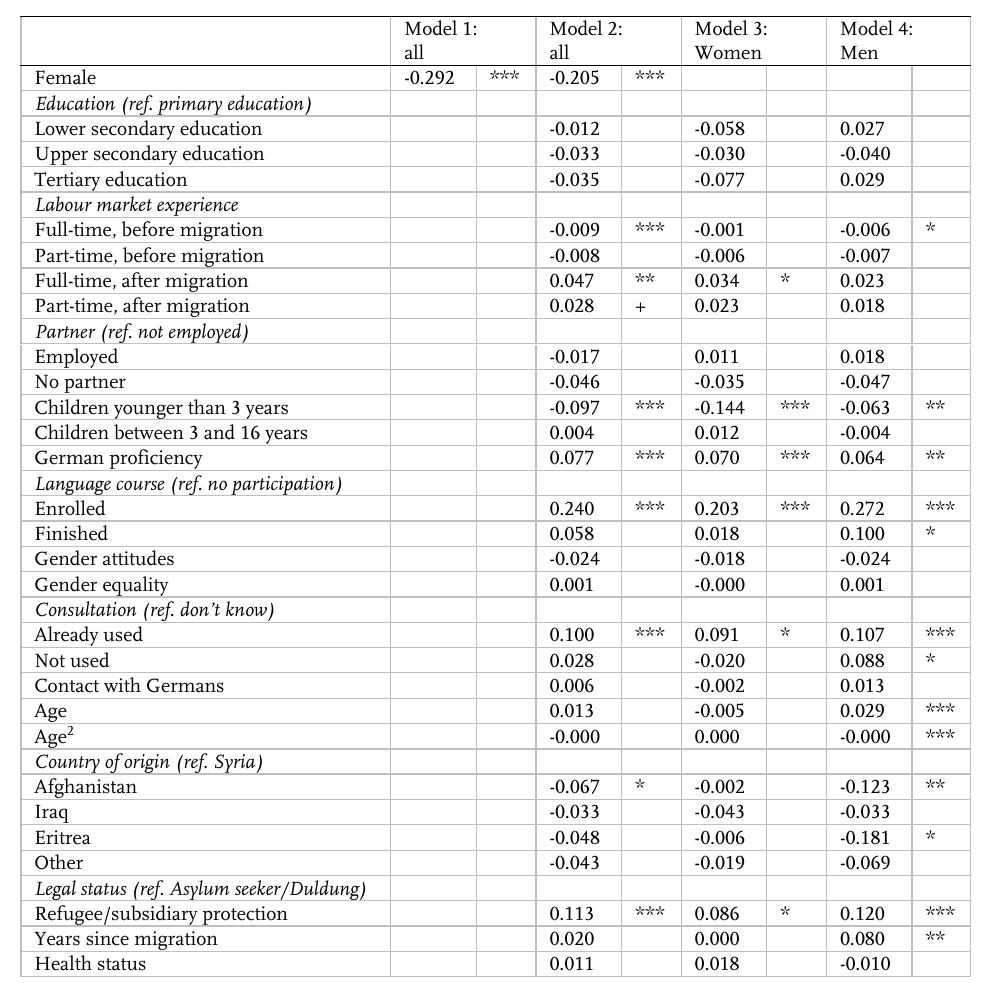
Table A.2 : Results from logistic regression (1: Labour market participation; 0: No labour market participation), pooled models and models by gender, average marginal effects